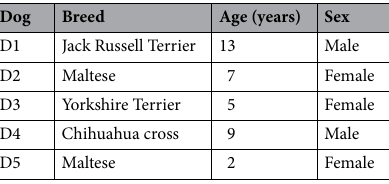
Table 1. Studied animals. General information on the breed, age and sex of the sampling dogs